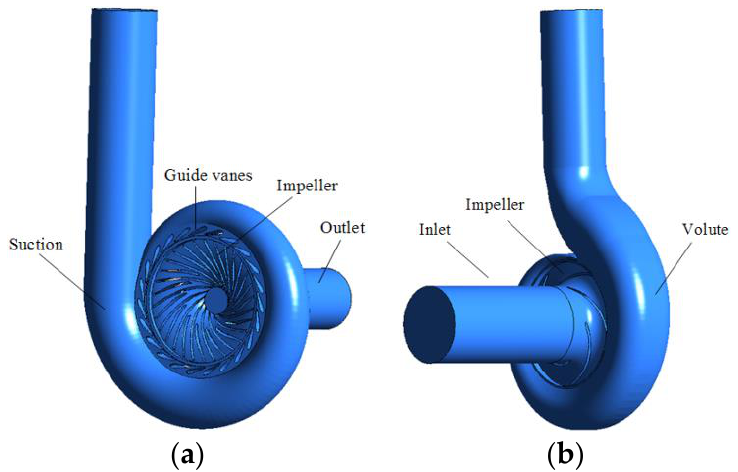
Figure 2. Computational domain. ( a ) Turbine section. ( b ) Pump section.